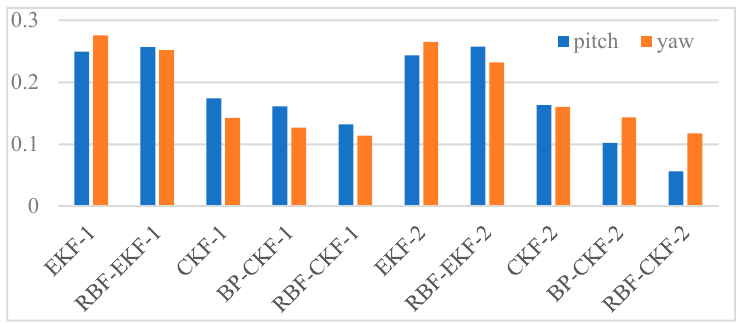
Figure 13. Comparison of RMSE among different methods of two groups of experiments. Table 4. Maximum errors and RMSE among different methods of two groups of experiments (degree).